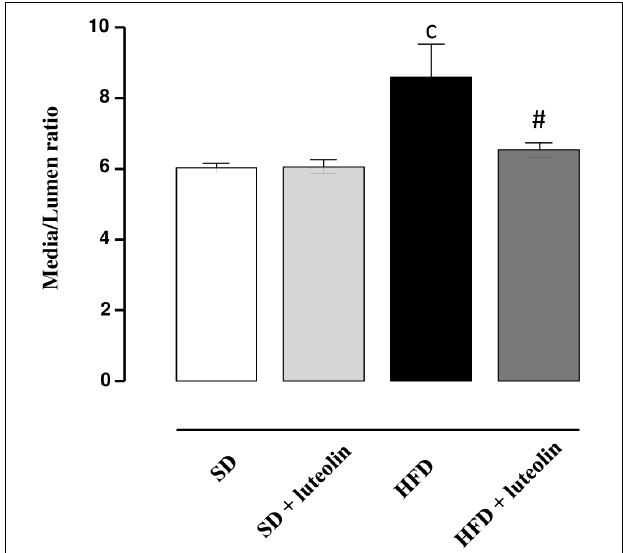
FIGURE 4 | Media-lumen ratio of mesenteric arteries from mice fed with SD, SD plus treatment with luteolin (10 mg/Kg/day), HFD or HFD plus treatment with luteolin (10 mg/Kg/day) for 8 weeks. Each column represents the mean ± SEM of five animals. c P < 0.001, significant difference vs. SD; # P < 0.001 significant difference vs. HFD. Statistics: two-way analysis of variance followed by Newman–Keuls test.